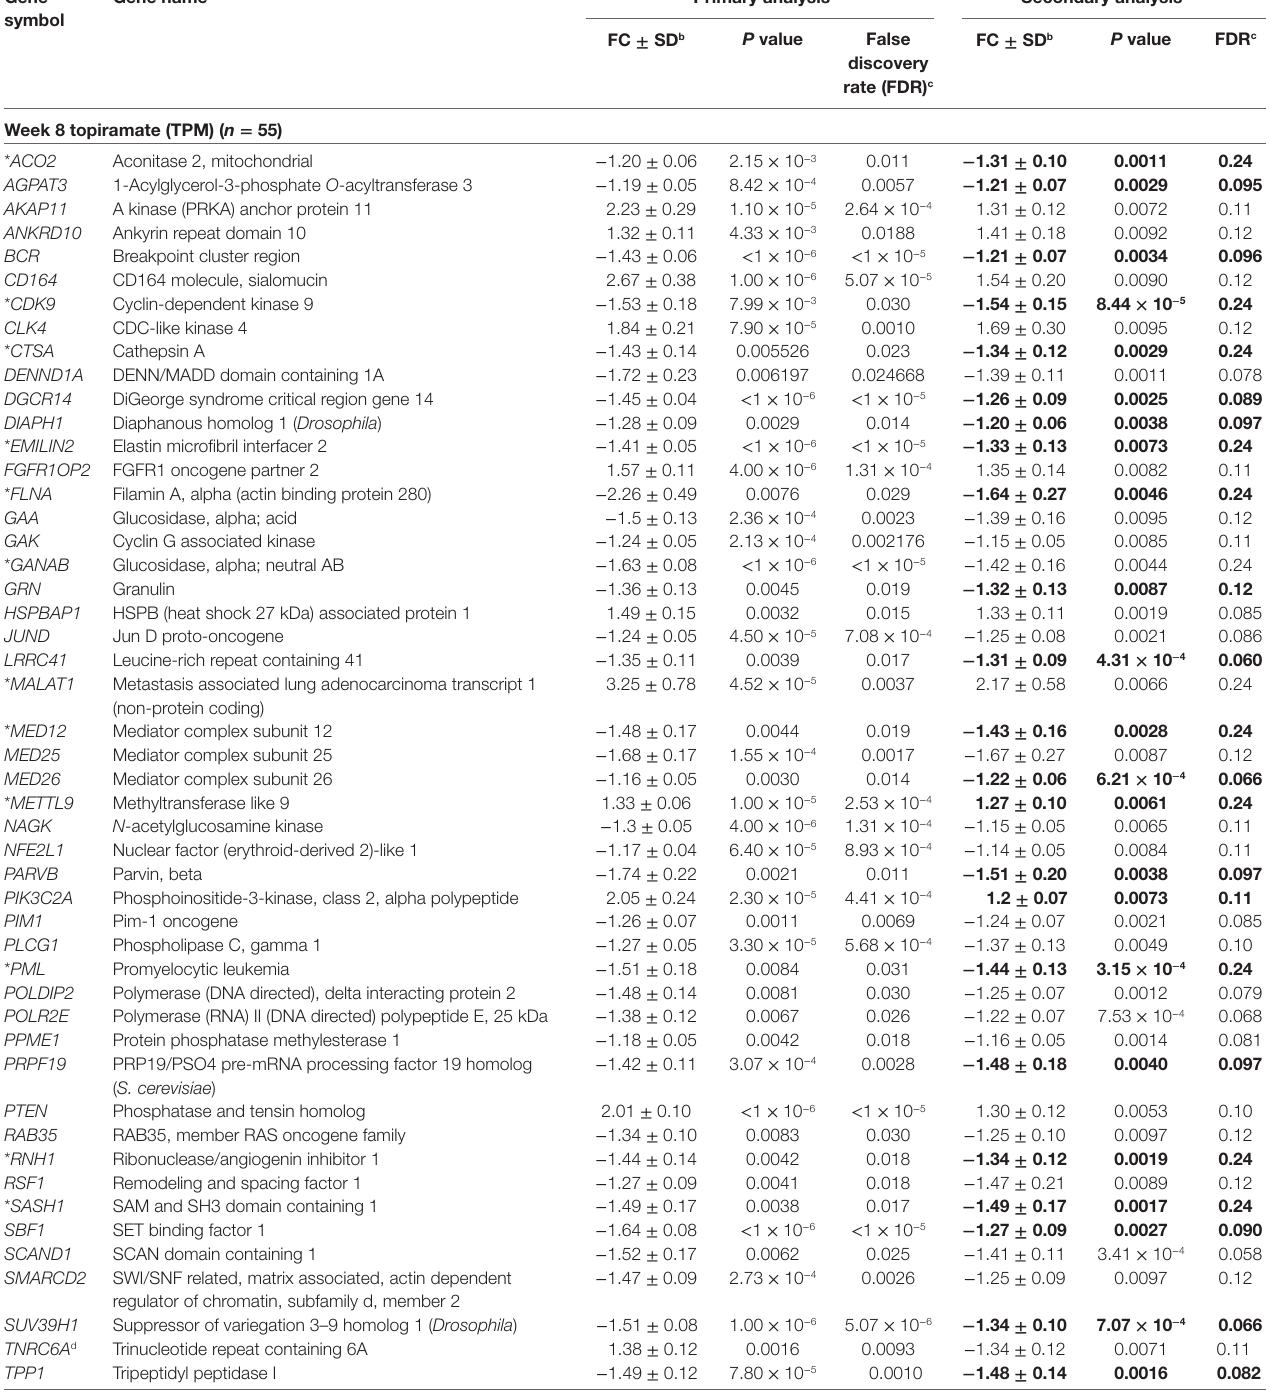
TaBle 3 | A list of significantly modulated genes detected in both primary analysis and secondary analysis ( n = 92).